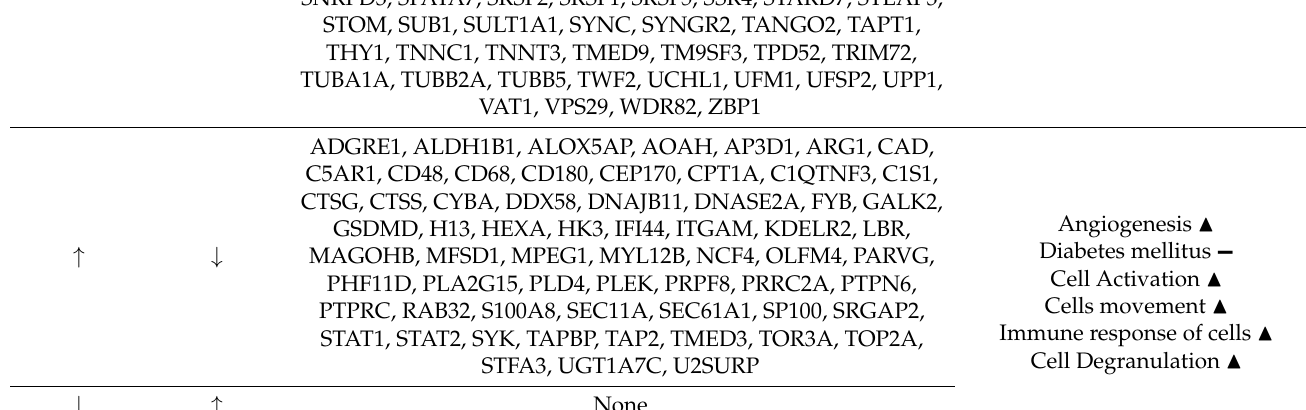
SF vs. SE mice (Supplementary Table S3 and Figure 3G). For instance, some proteins related to atherosclerosis were down-regulated in SF, such as ARG2, CD14, CD44, engulfment, and cell motility protein 1 (ELMO1), neutrophil gelatinase-associated lipocalin (LCN2),